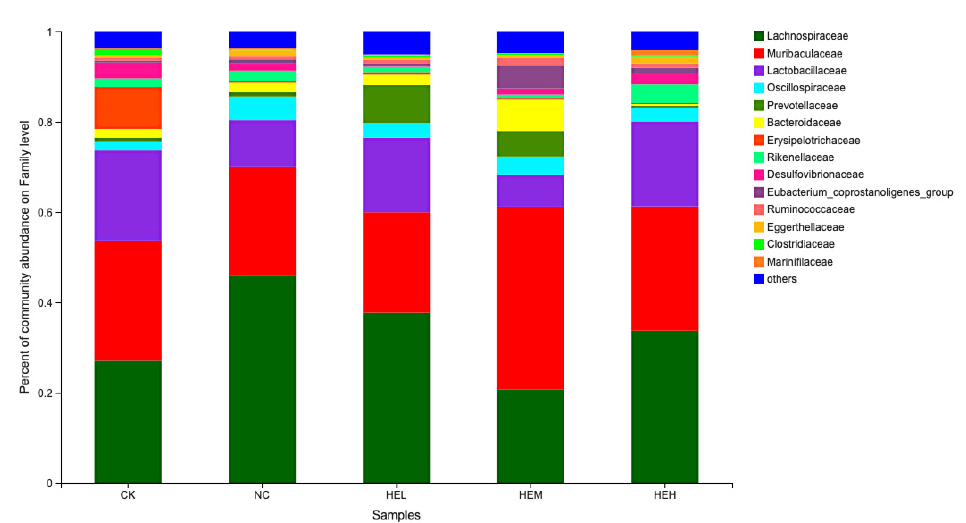
Figure 7. The effect of different treatments on the composition of mice gut microbes. Histogram of family-level communities.